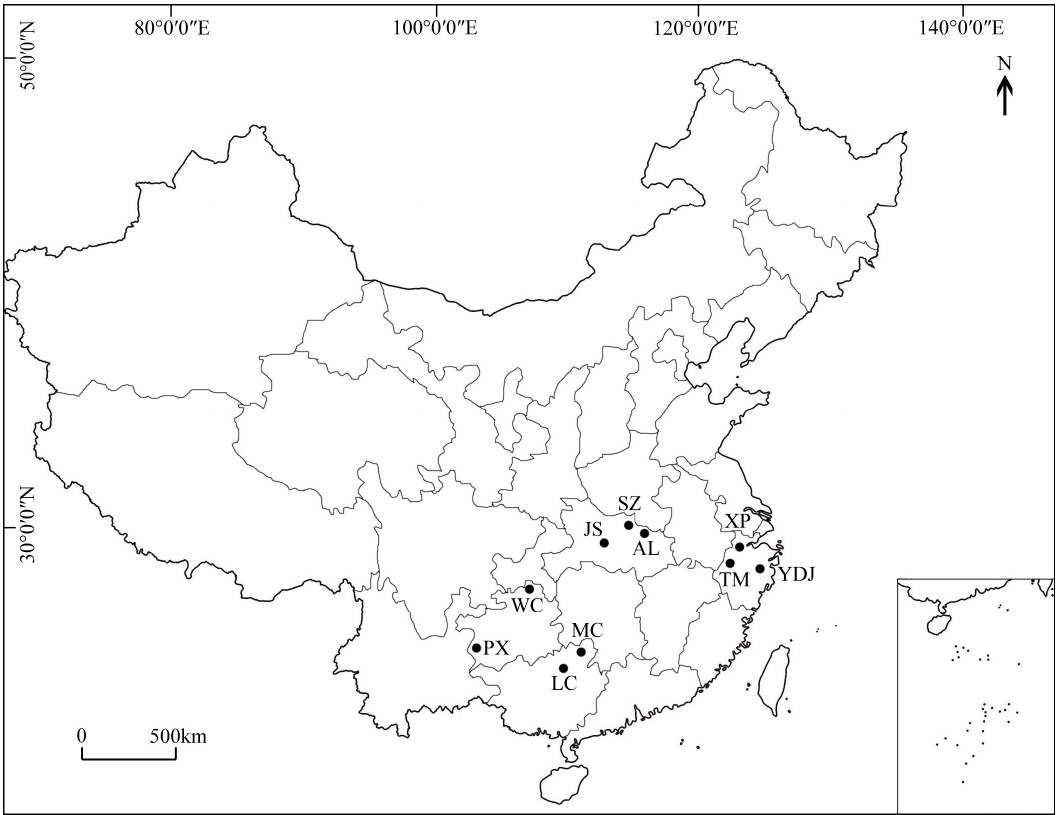
Figure 1. Geographical distribution of the 10 populations of G. biloba . The 10 populations come from the major areas with centralized distributions of ancient Ginkgo trees in China. Codes for the population are given in Table 1.